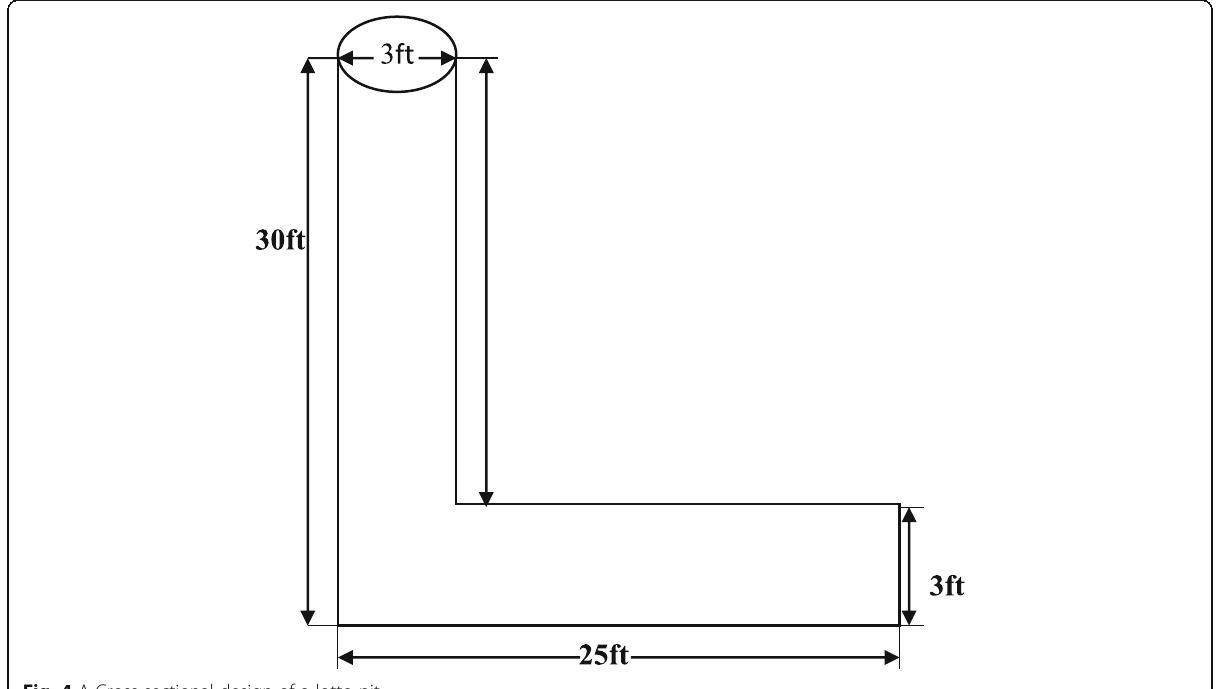
Fig. 4 A Cross-sectional design of a lotto